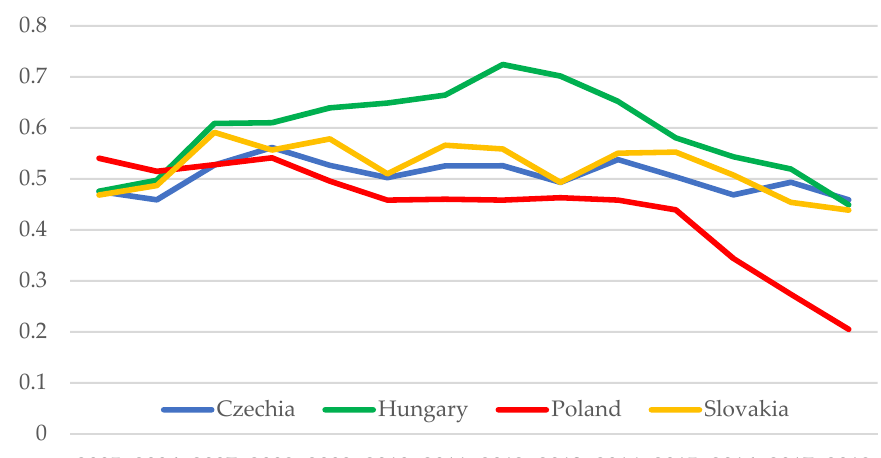
Figure 2. Value of the synthetic measure of the V4 countries in the years 2005–2018. Source: own calculations on the statistical data of Eurostat [69].